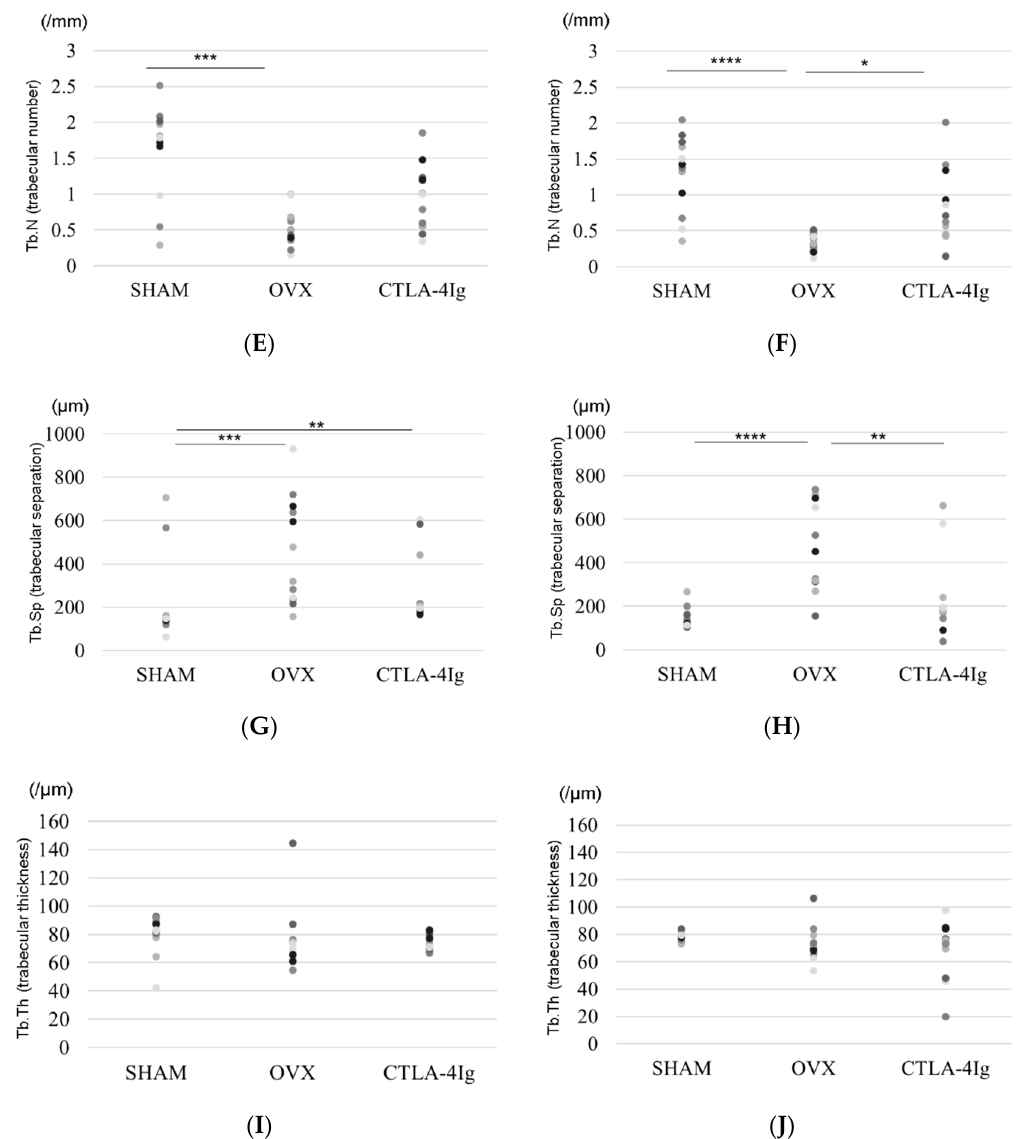
Figure 2. Micro ‐ CT analyses of the distal femoral metaphysis and the proximal tibial metaphysis. Three ‐ dimensional images of the distal femoral metaphysis ( A ) and the proximal tibial metaphysis ( B ); ( C ) bone volume / tissue volume (BV / TV, %) (distal femoral metaphysis); ( D ) BV / TV (%) (proximal tibial metaphysis); ( E ) trabecular number (Tb.N, per mm) (distal femoral metaphysis); ( F ): Tb.N (/mm) (proximal tibial metaphysis); ( G ) trabecular separation (Tb.Sp, μ m) (distal femoral metaphysis); ( H ) Tb.Sp ( μ m) (proximal tibial metaphysis); ( I ): trabecular thickness (Tb.Th, μ m) (distal femoral metaphysis); ( J ) Tb.Th ( μ m) (proximal tibial metaphysis). Data are shown as scatter plots (* p < 0.05, ** p < 0.01, *** p < 0.005, **** p < 0.001; n = 12 in each group).